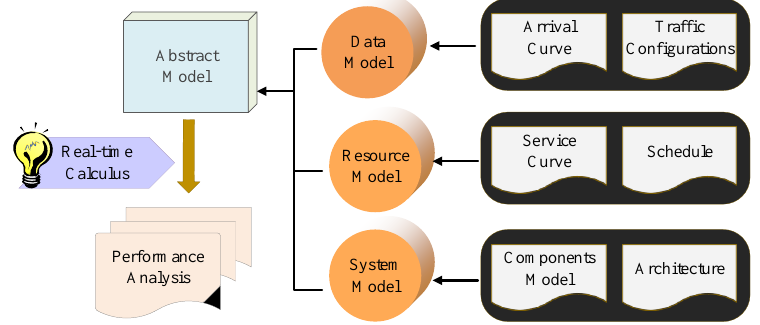
Figure 3. Performance analysis framework of TTEthernet.